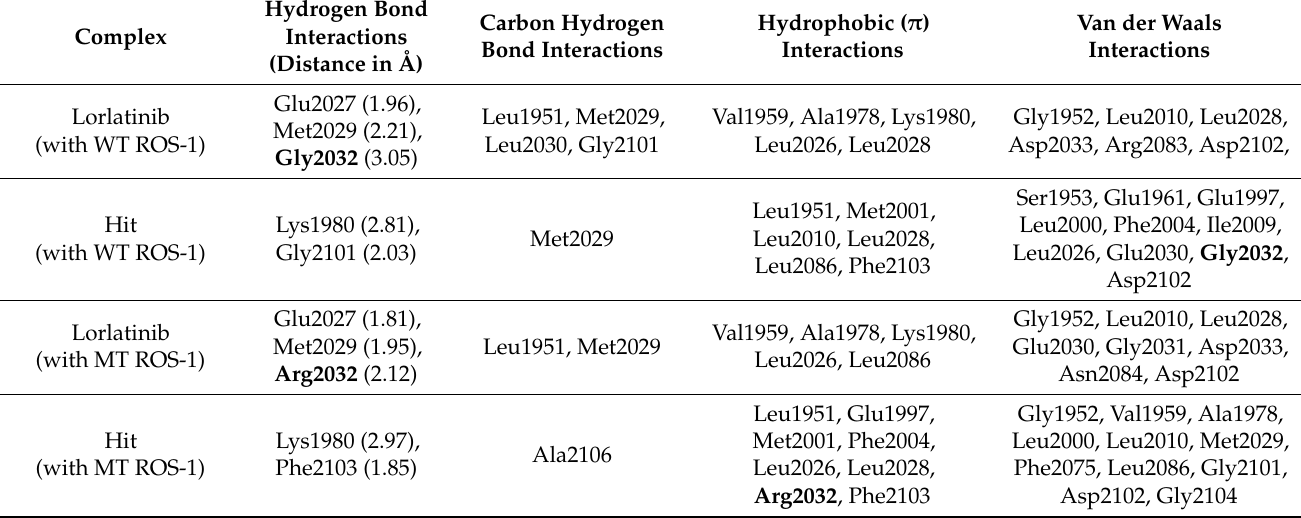
Figure 6. Binding mode of ( A ) lorlatinib and ( B ) Hit compound in the mutated (MT) ROS-1 catalytic pocket and molecular interactions with key residues. Table 3. Molecular interactions between the compounds (lorlatinib and Hit) and the active site residues of wild-type (WT) and mutated (MT) ROS-1 kinase acquired from stable molecular dynamics (MD)